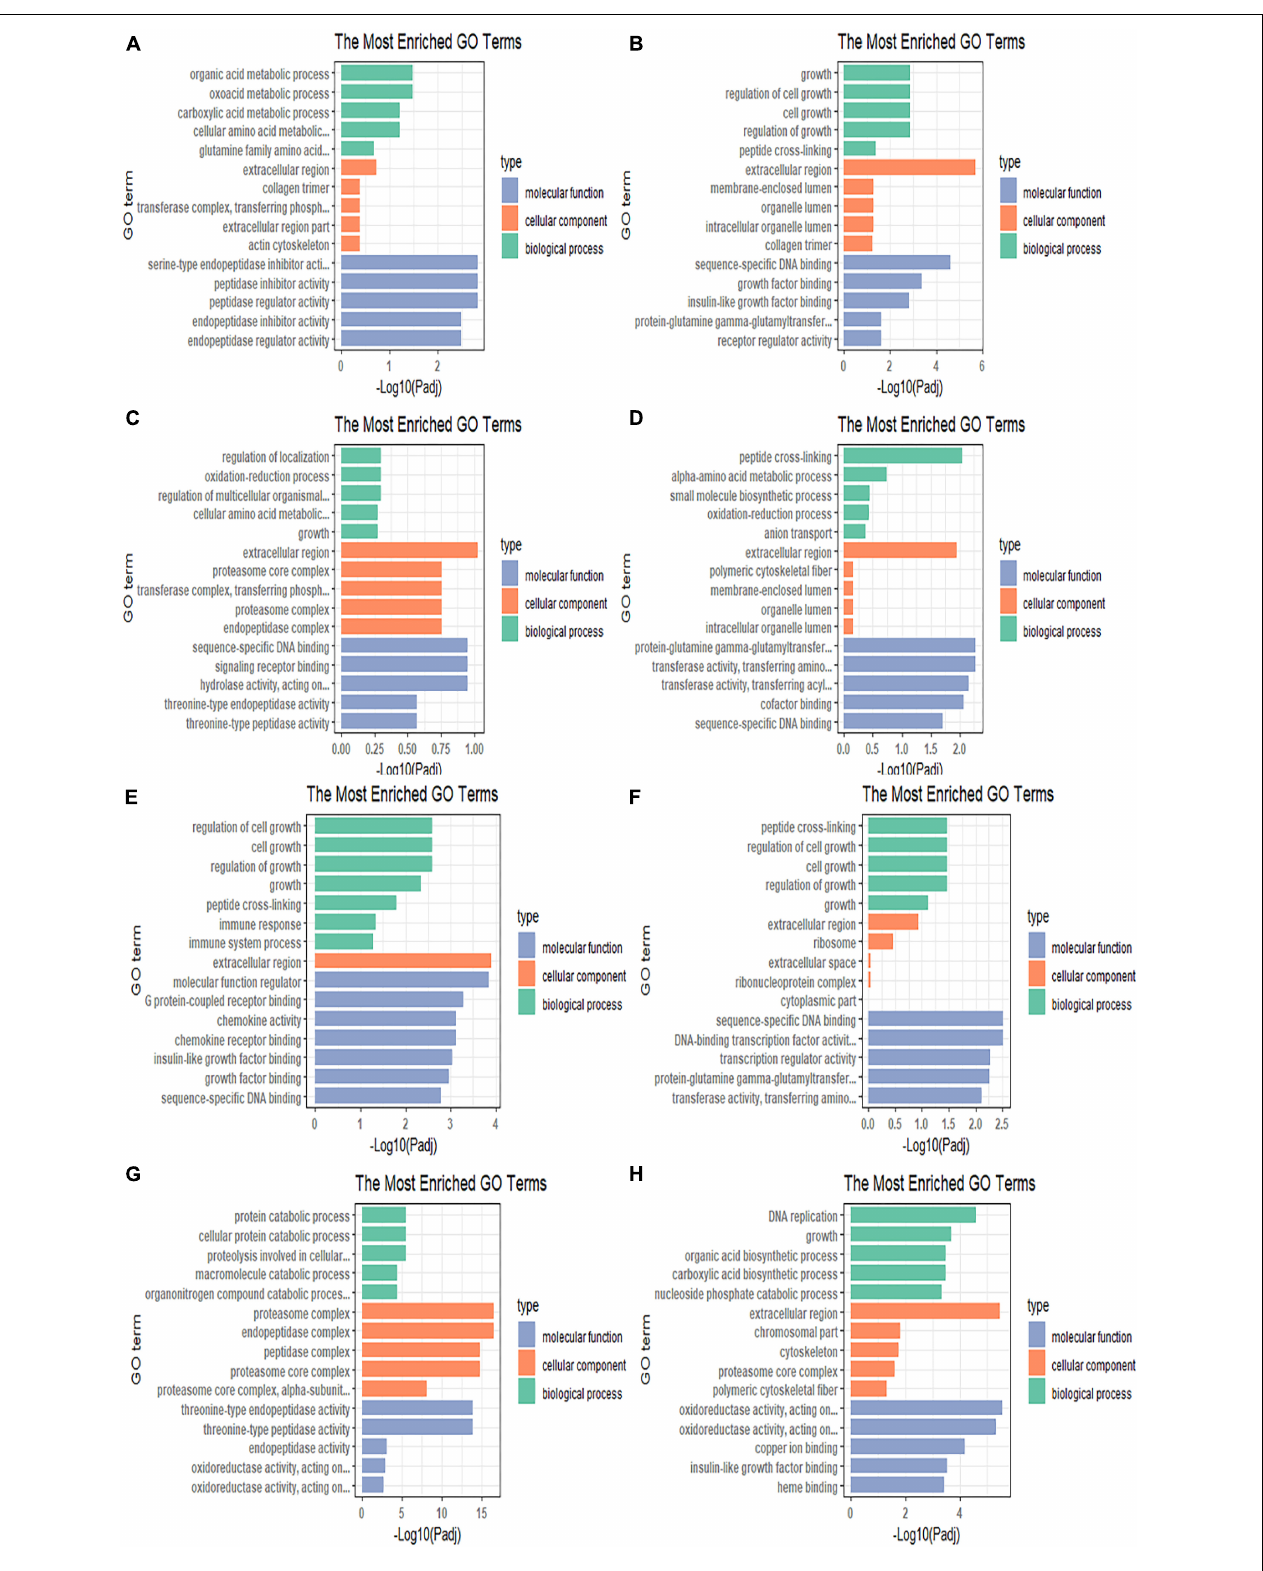
FIGURE 4 | Gene Ontology enrichment bar chart illustrating the differentially expressed genes enriched in GO terms and the counts of genes for each GO terms in the (A) 4 vs. 0 h, (B) 8 vs. 0 h, (C) 12 vs. 0 h, (D) 24 vs. 0 h, (E) R12 vs. 0 h, (F) R24 vs. 0 h, (G) R12 vs. H24 h, and (H) R24 vs. H24 h.